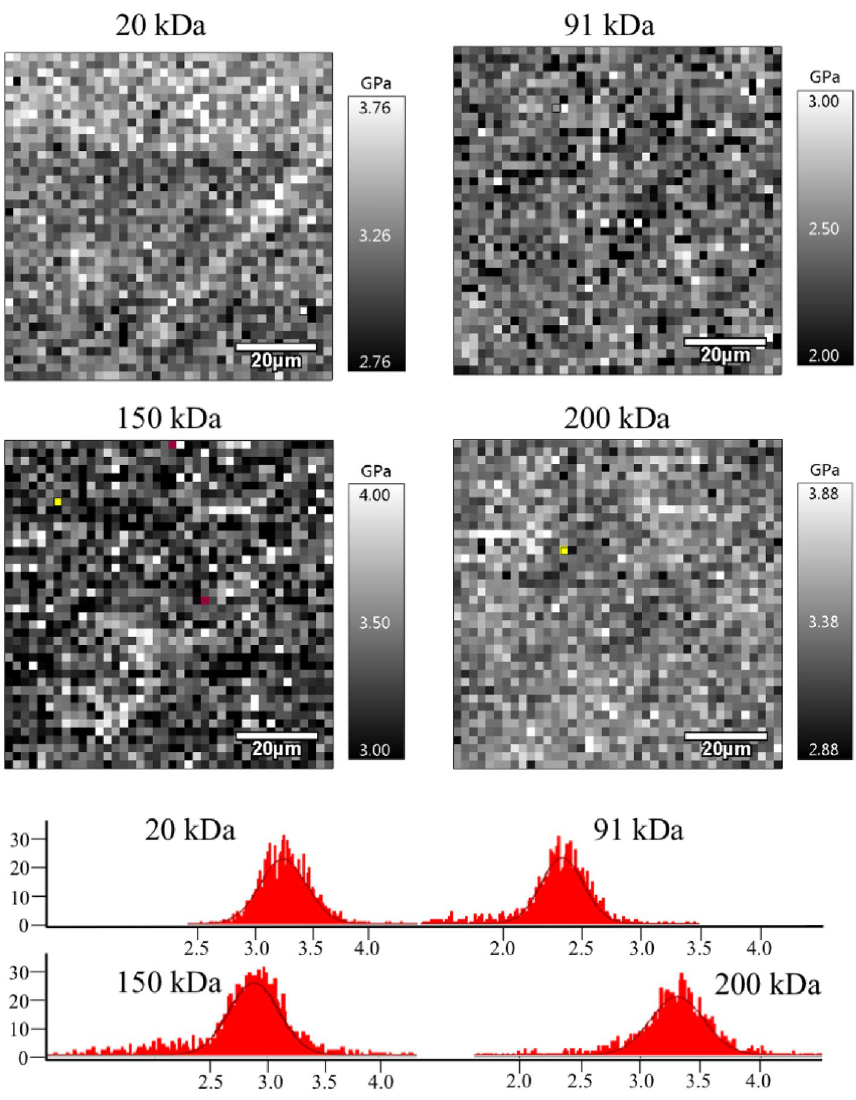
Figure 8. Force spectroscopy maps of coatings with uniform MWD and corresponding histograms of the elastic modulus. The greyscale shows the stiffness—the white colour corresponds to the highest